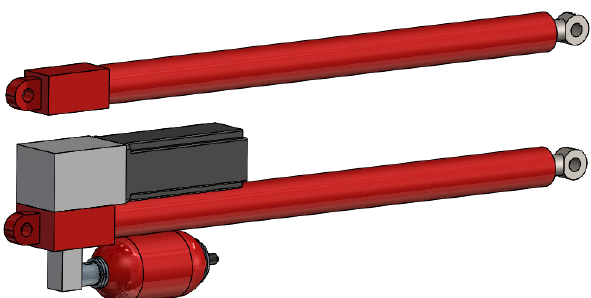
Figure 34: Size comparison – main arm cylinder (simplified CAD